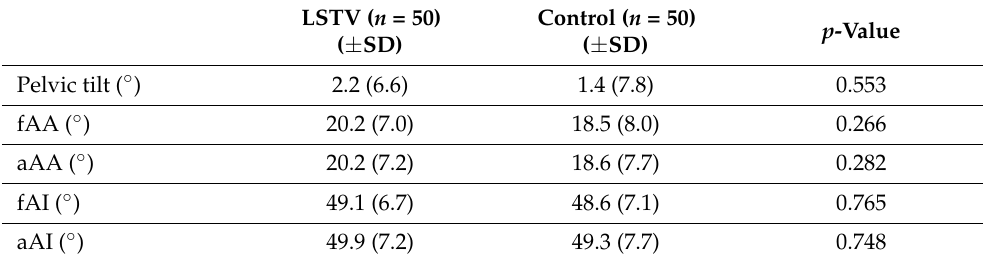
Table 5. Acetabular orientation in patients with LSTV and the control